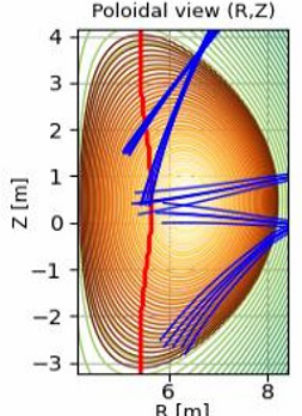
Fig. 6. EC rays read from the waves IDS generated by the TORBEAM code [3], for an ITER DT baseline 15MA/5.3T scenario; the cold resonance layer is displayed in